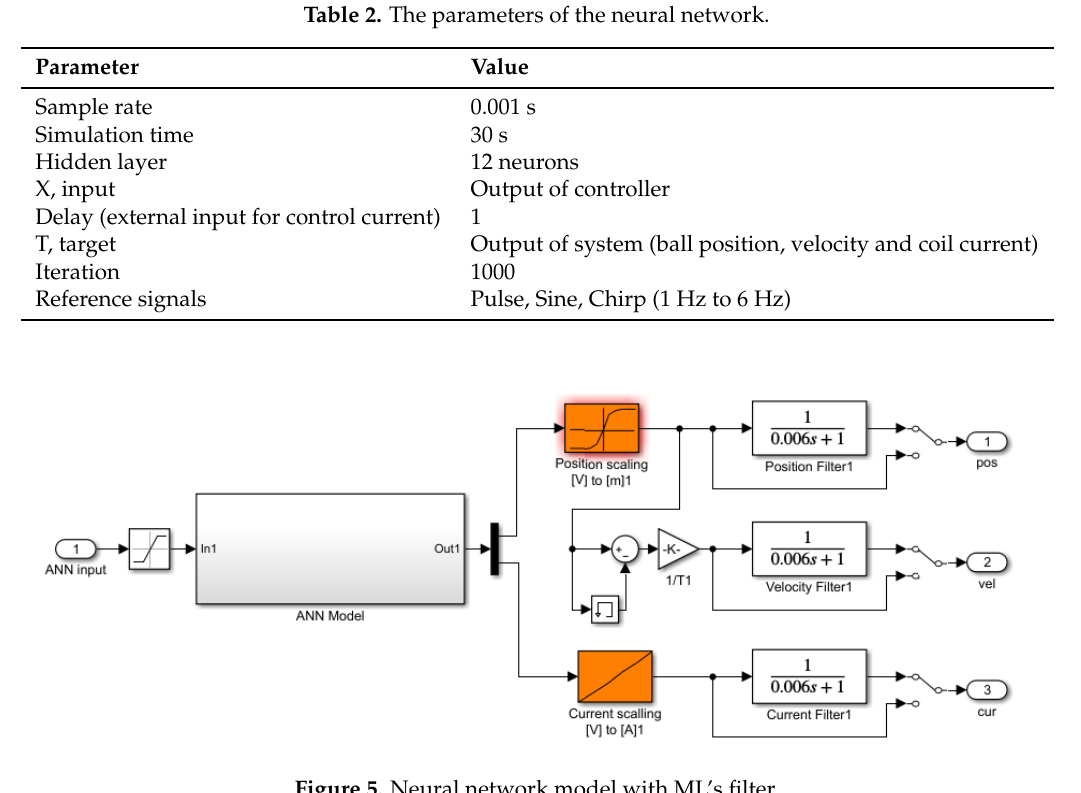
Figure 5. Neural network model with ML’s